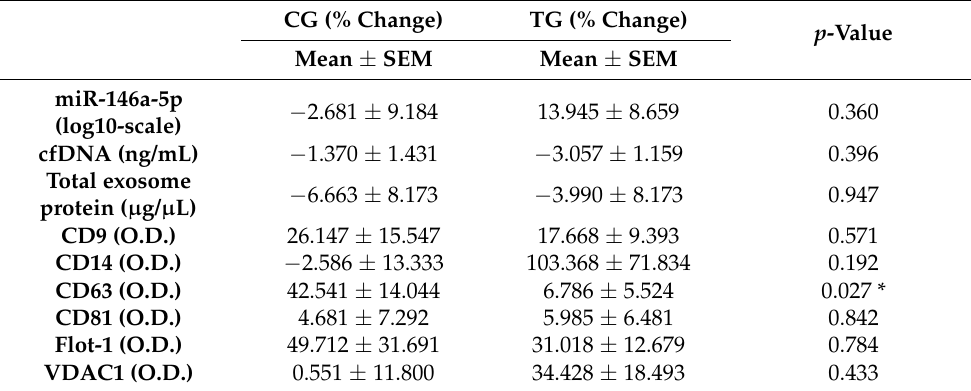
Table 5. Effects of an 8-week resistance training on plasma miR-146, cfDNA, total exosome protein content, and exosome cargo between CG and